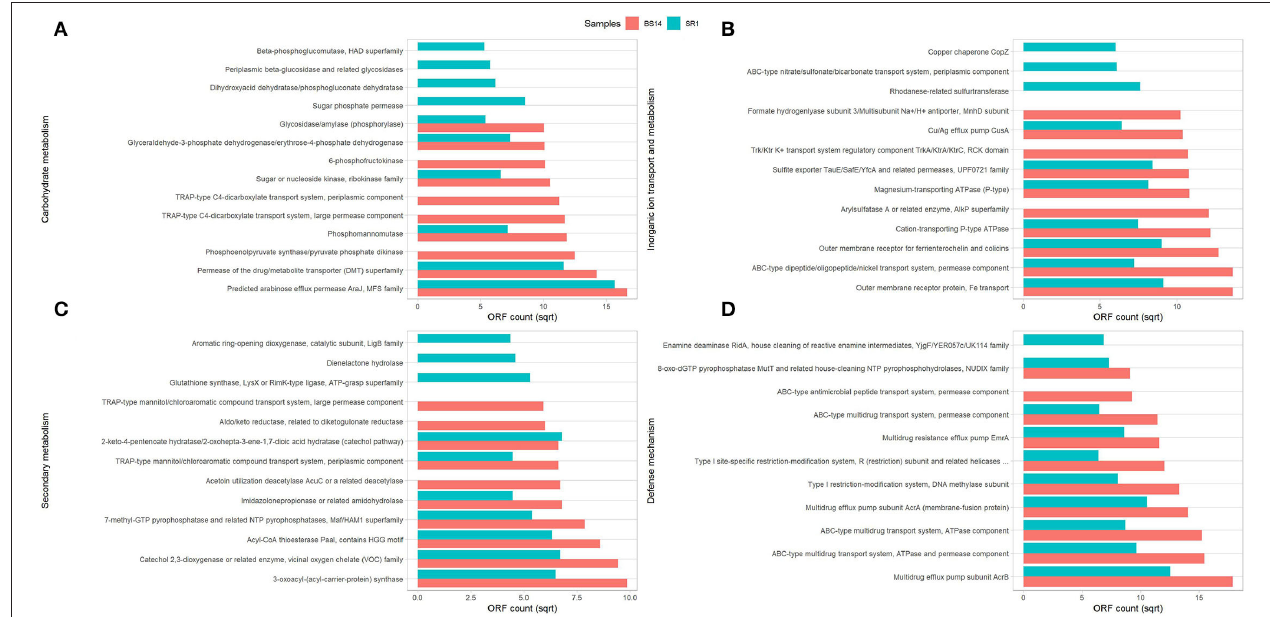
FIGURE 4 | Representation of top 10 abundant features of Clusters of Orthologous Genes (COG) category for BS14 and SR1 involved in (A) carbohydrate metabolism; (B) inorganic ion transport and metabolism; (C) secondary metabolism; and (D) defense mechanism.